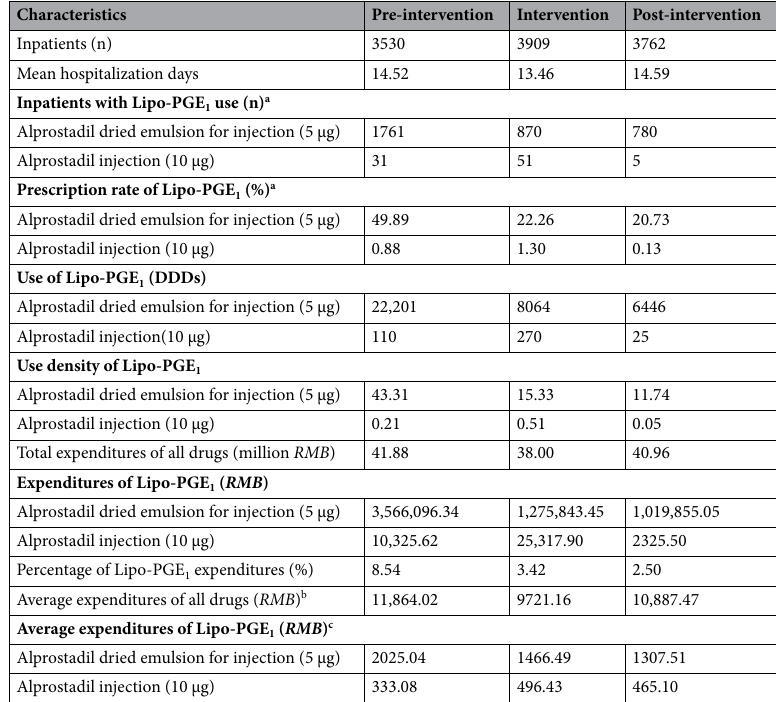
Table 2. The use and expenditure (RMB) of Lipo-PGE 1 for all neurosurgical patients in pre-, during, and post- intervention periods. a 28 and 42 patients received successively two formulations of Lipo-PGE 1 before and after the intervention, respectively. b All patients. c Patients with Lipo-PGE 1